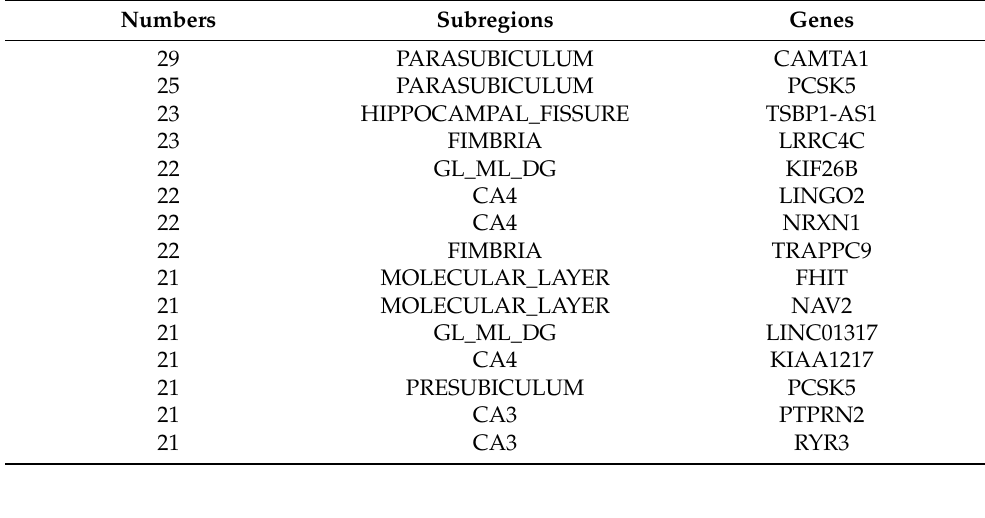
Table 2. The important “subregion-gene pairs” with numbers greater than 20. GL_ML_DG = the granule cell layer and molecular of the dentate gyrus; CA4 = cornu ammonis 4 region.